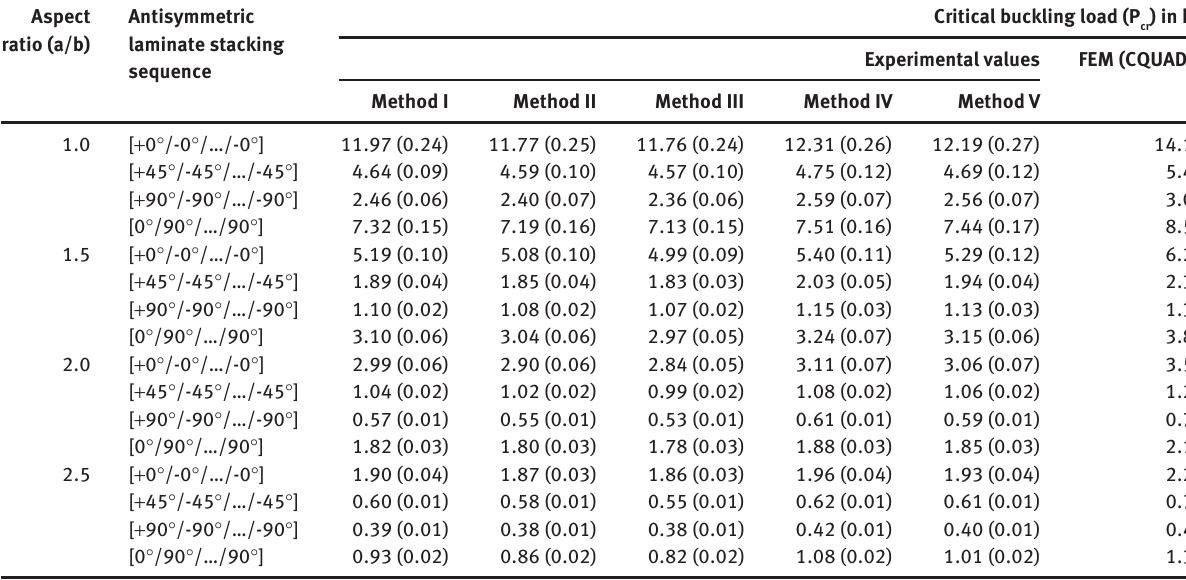
The numbers in parentheses represent the standard deviation.